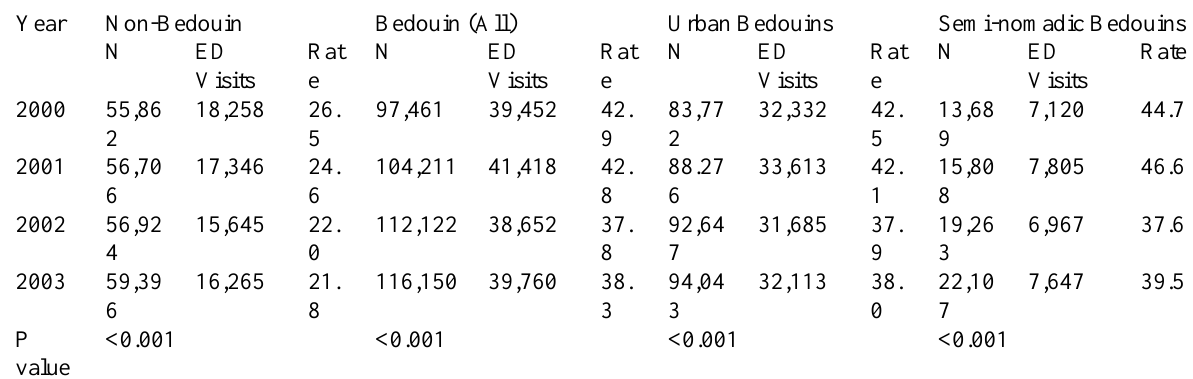
Trends in rates of ED visits by Bedouin patients,